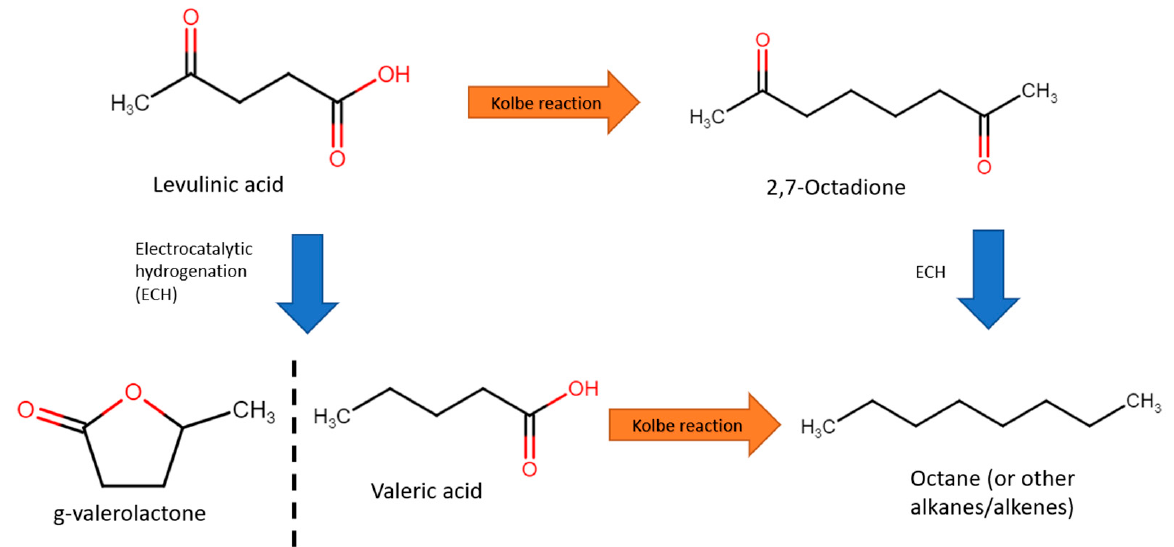
Figure 19. Reaction pathways from levulinic acid to octane.